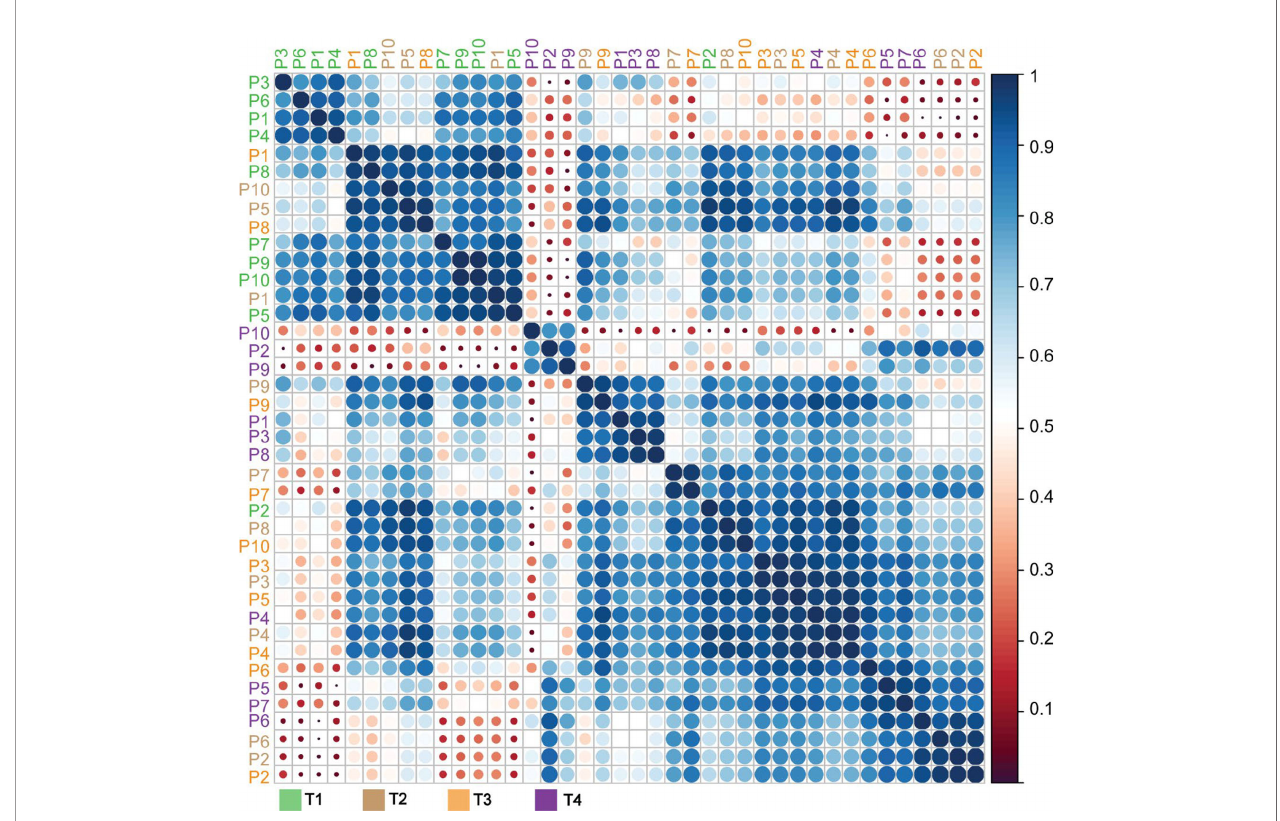
FIGURE 4 | Correlation matrix of a -1-antichymotryspin glycoproteoform pro fi les for all patients at all time points. Native mass spectra for each patient and time- points (10x4 spectra) were correlated with each other and clustered based on the derived Pearson correlation. Patients are color-coded according to the legend below the matrix. The extracted correlation is indicated both by the scale bar on the right, with dark blue representing the highest correlation, and the size of the circles, whereby bigger circles represent higher correlations than smaller